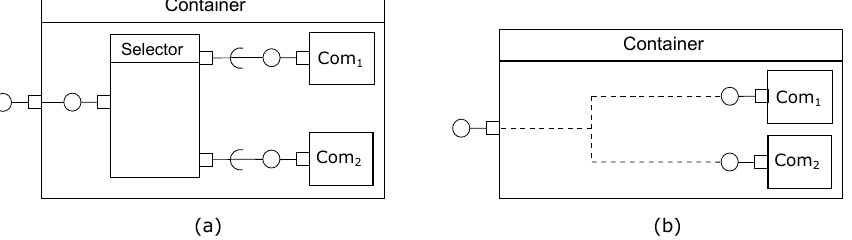
Figure 17. Selector pattern, which forwards requests to different communication devices depending on the project configuration: ( a ) Existing design that uses a dedicated object. ( b ) Updated design that uses an enhanced